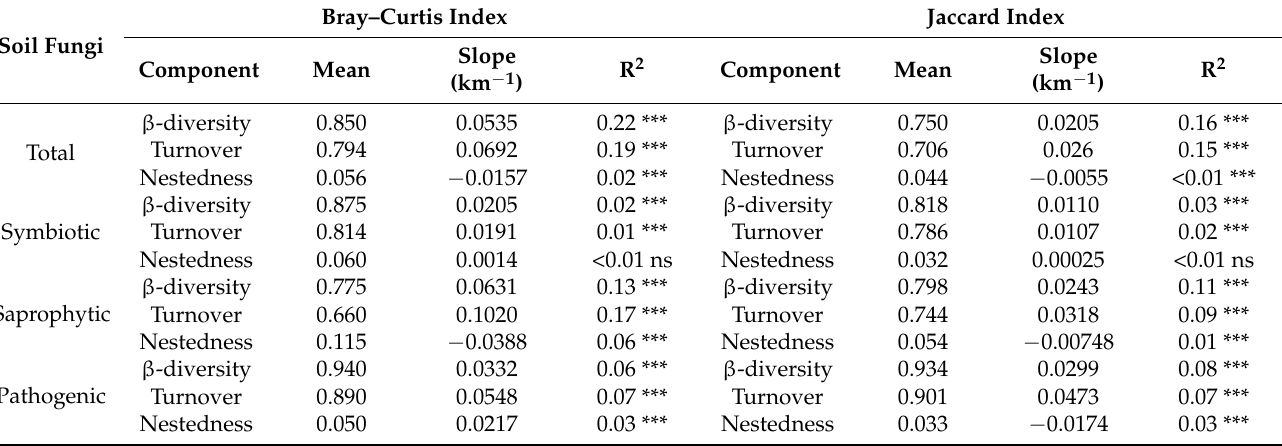
Table 2. General linear regression results between altitude distance and soil fungal β -diversity or its components as calculated by Bray–Curtis and Jaccard